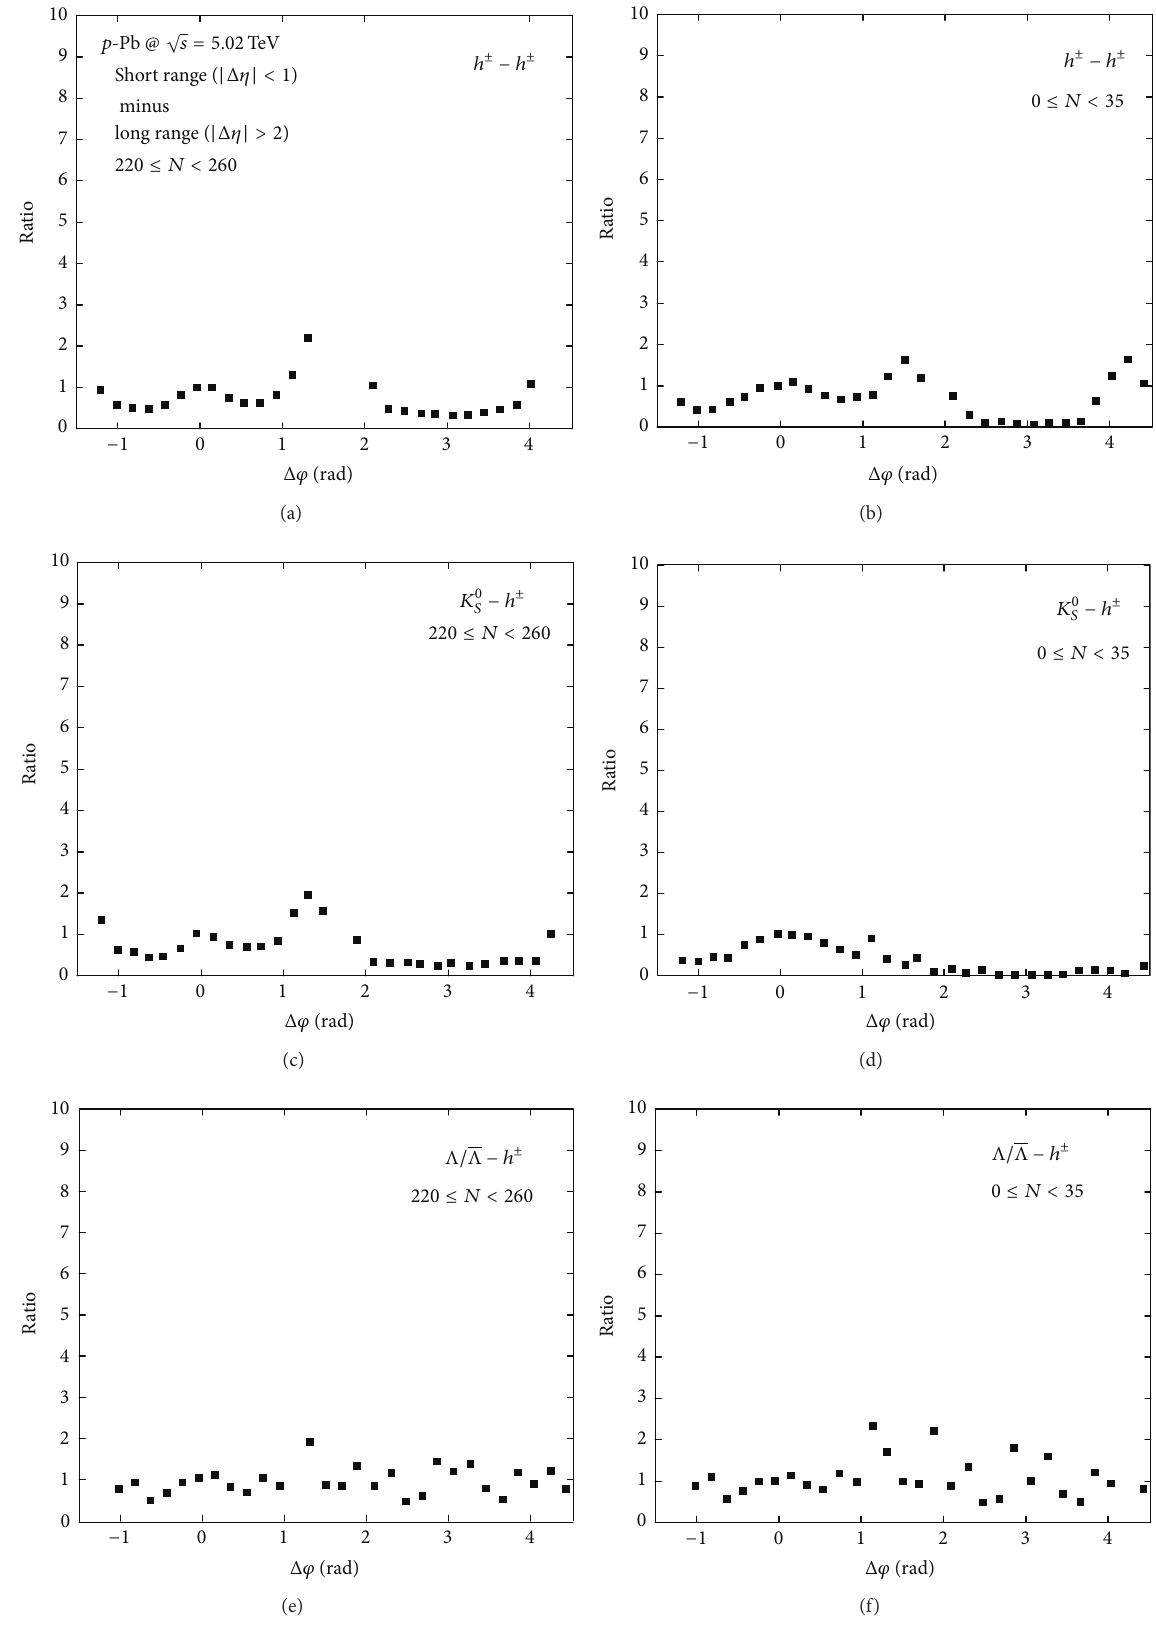
Figure 6: The ratio of fit to data in Figure